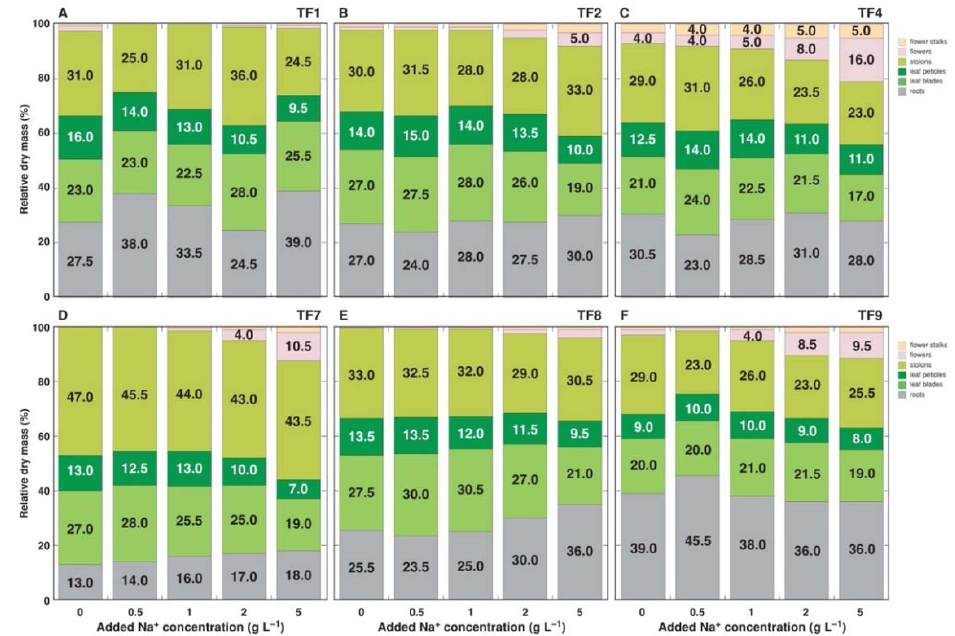
Figure 5. Changes in biomass partitioning in Trifolium fragiferum plants of different accessions due to increasing substrate salinity. ( A ), accession TF1; ( B ), accession TF2; ( C ), accession TF4; ( D ), accession TF7; ( E ), accession TF8; ( F ), accession TF9.